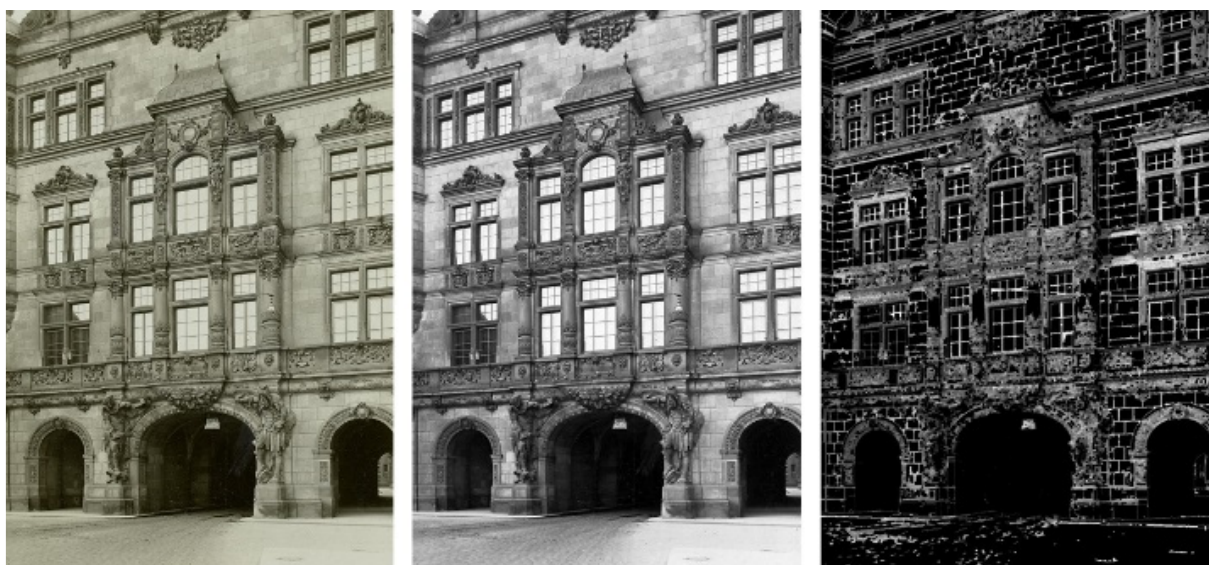
Figure 2. Original historical image (left), image after histogram equalization and bilateral filtering (middle), image after Canny edge detector and closing